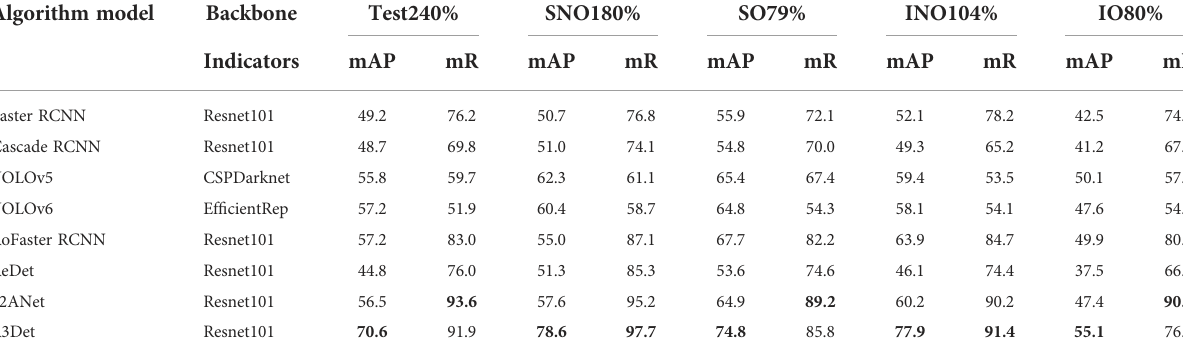
detection algorithm is YOLOX, the second-stage detection algorithm is Faster RCNN, and the rotation detection algorithm is R3Det and S2ANet. Take Test240 data as the test TABLE 3 Comparison of detection results when the input image is 1000*600. Algorithm model